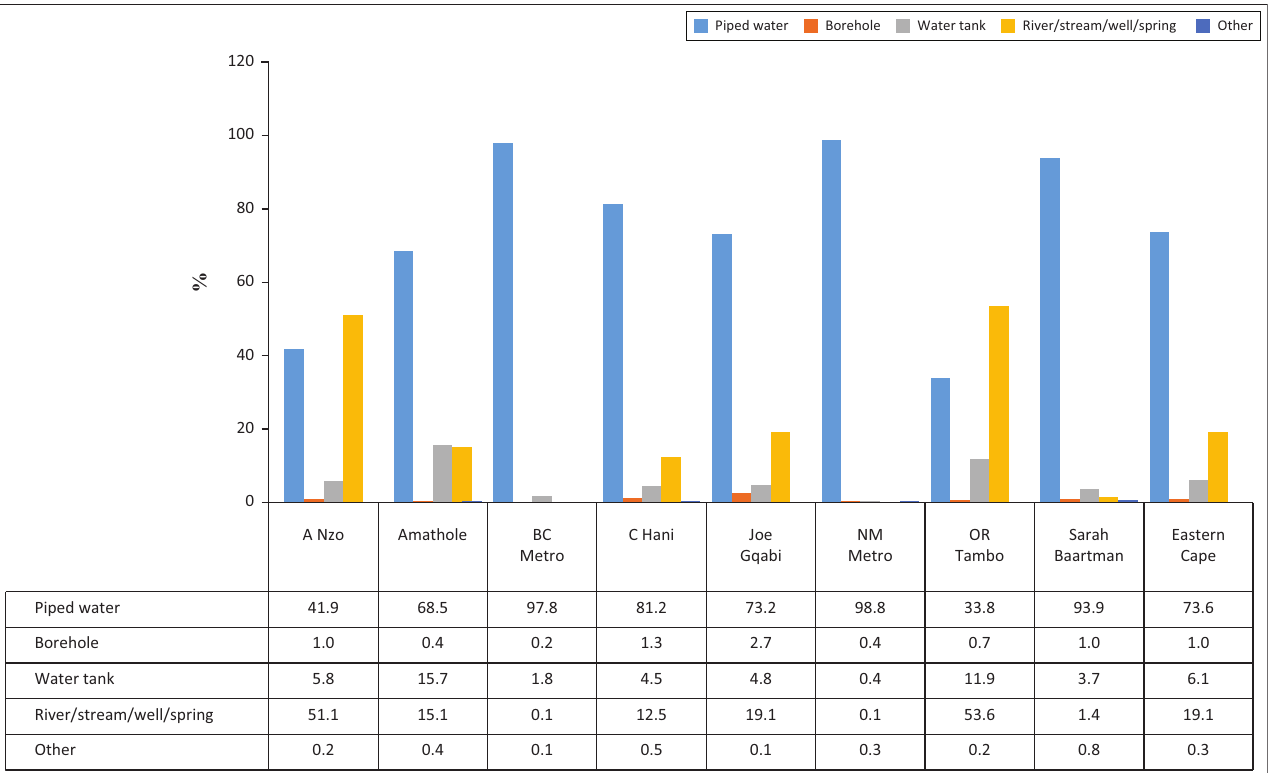
FIG URE 3: Per cent of households with access to piped water in Eastern Cape province,